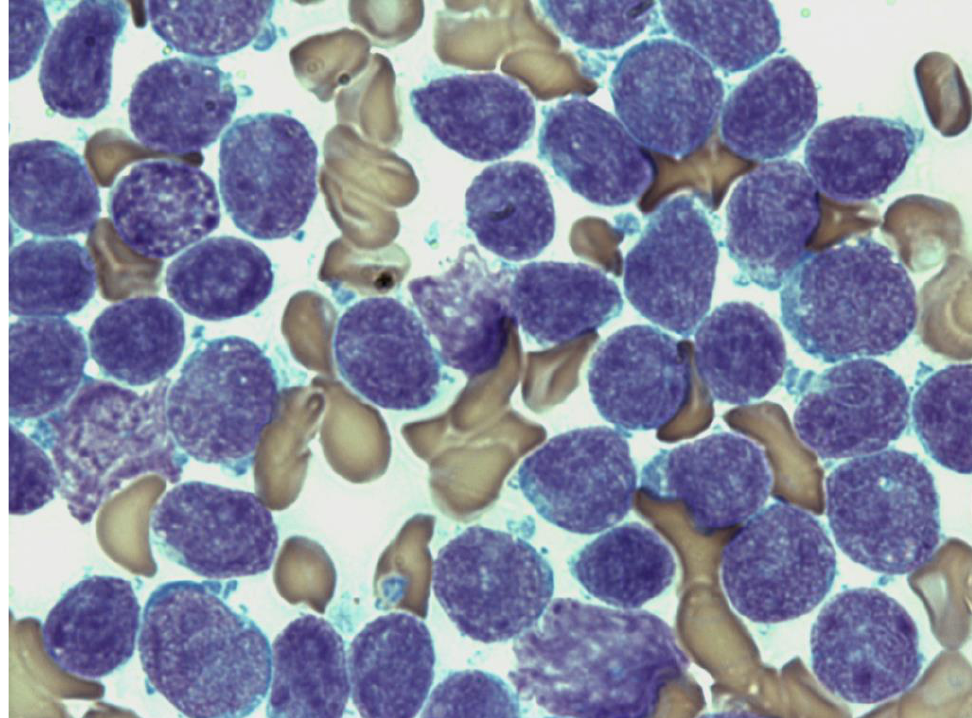
Figure 1. Bone marrow hematological cells from aspirate smear sample. The number of small- to medium-sized blasts with scant cytoplasm increased in up to 98% of absolute nucleated cells and the number of megakaryocytes and their precursors decreased. The granulocytic series and the erythroid series cells were also suppressed. (Wright stain, ×